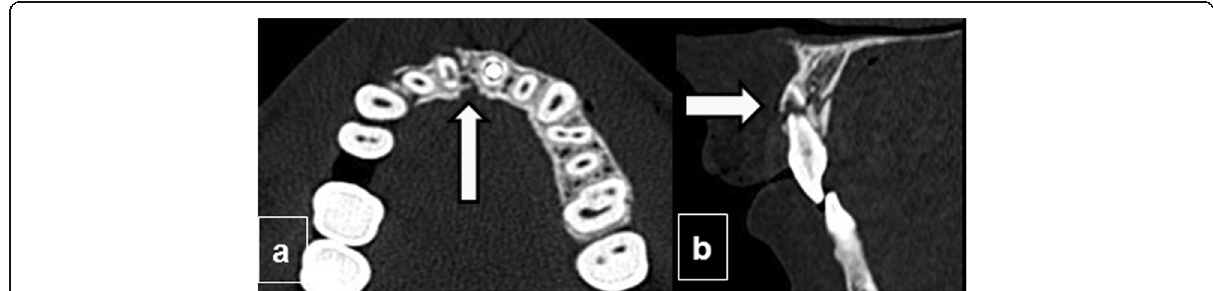
Fig. 15 Alveolar process fracture. Axial ( a ) and sagittal ( b ) unenhanced CT images show a fracture of the upper alveolar ridge with associated dental root fracture (arrows)